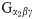
The time course of various components under different levels of uniform stimuli.First row—Gα2βγ and Gβγ: Second row—Gα and Gα*; Third row:—Ric8 and Ric8*. Fourth row—The dose dependent dissociation at steady state. Left: model prediction; Right: Dose-response curves for cAMP (dark blue), 2’-dcAMP(light blue), and 8-Br cAMP (green), and 5’ AMP (orange) from [43] with permission.